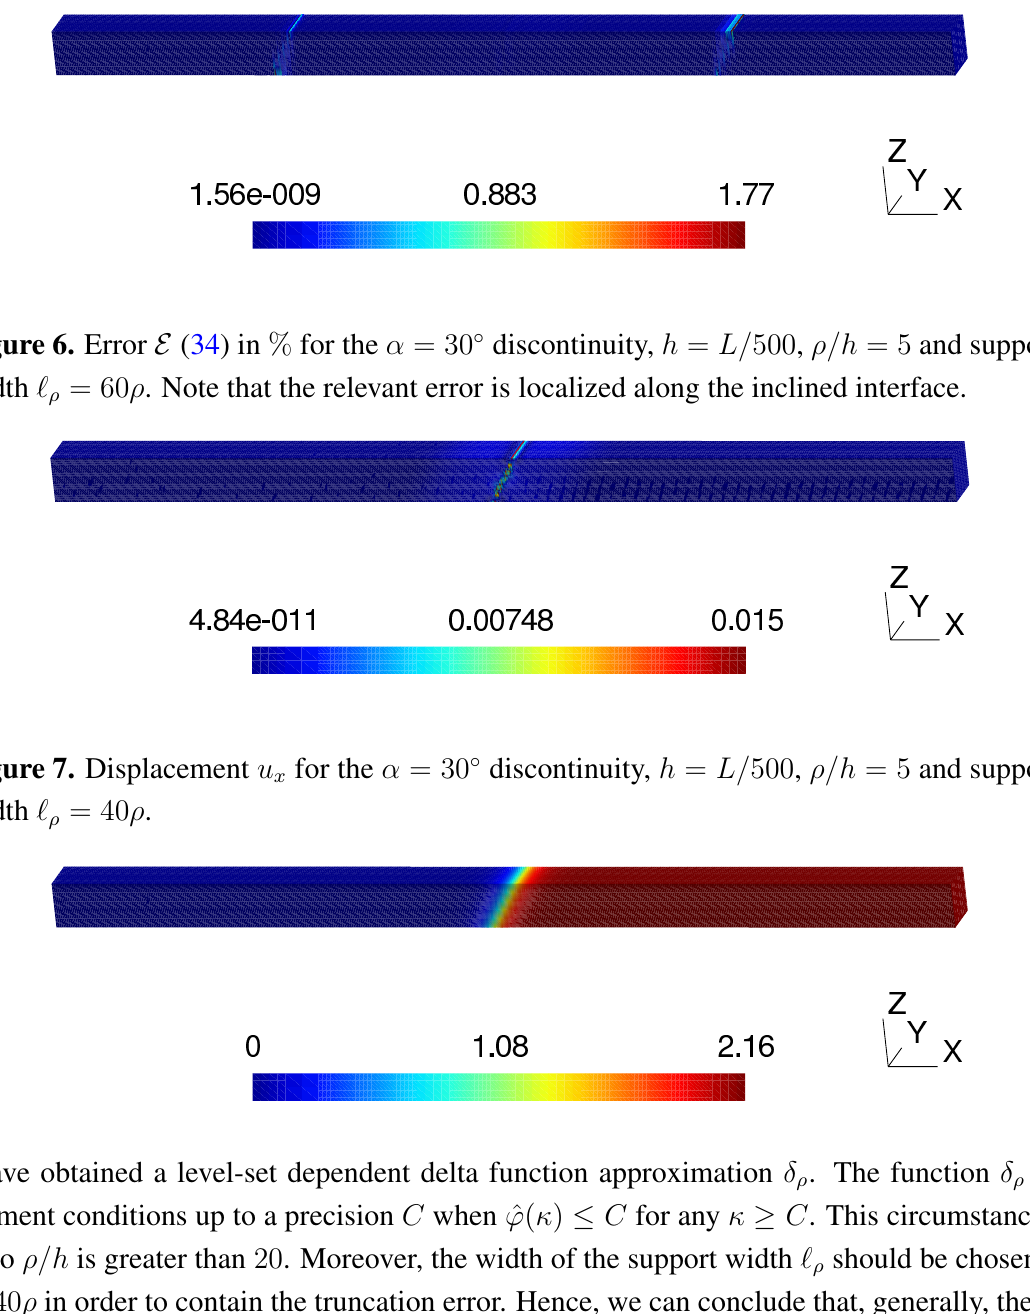
Figure 5. Error E (34) in % for the α = 30 ◦ discontinuity, h = L/ 500 , ρ/h = 5 and support = 40 ρ . Note that the truncation error is dominant. width ℓ ρ